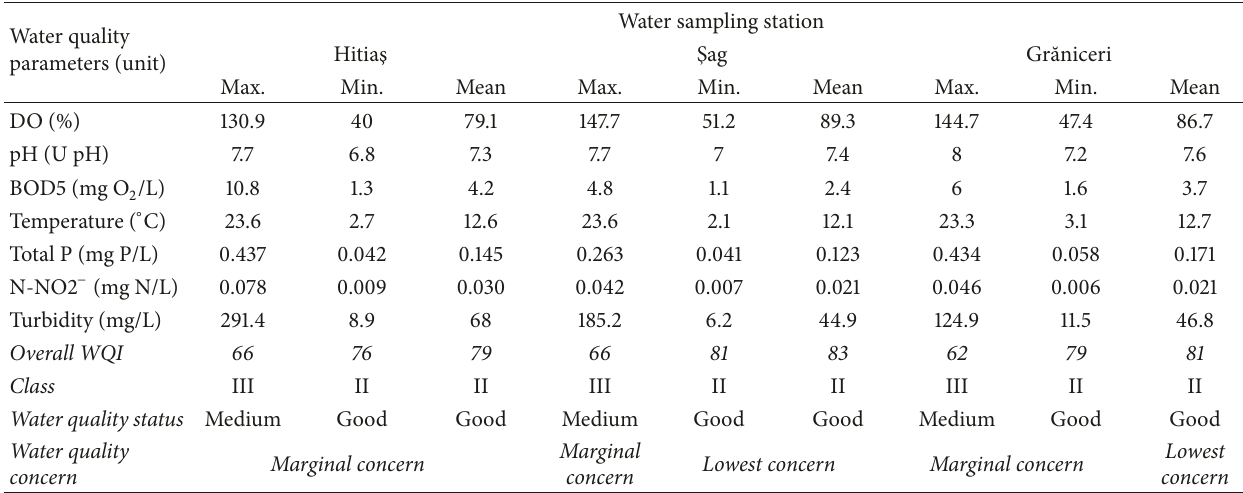
Table 3: Water quality status and WQI values at sampling stations from the Timis¸